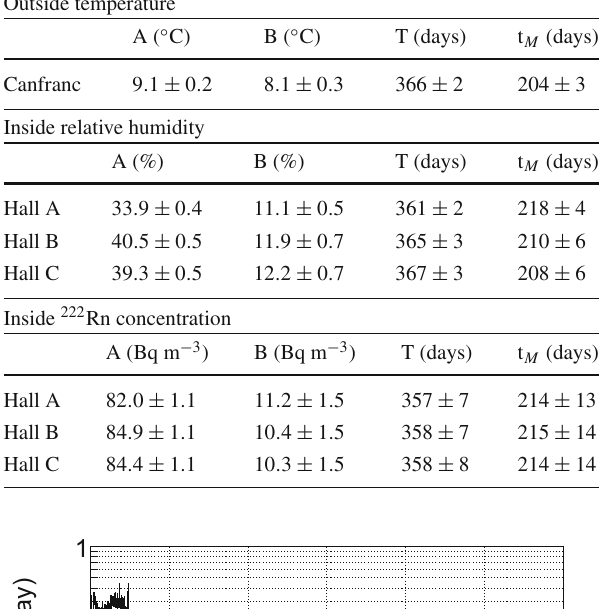
the inner volume of the shielding due to an accidental cut of the purging system. Second, we measured the efficiency at 1460.8 keV, (cid:4)( 1460 . 8 keV), using a source of 260 g of KCl located at several positions in the accessible volume around the HPGe, and another one of 20.6 g at several distances from the HPGe window. We have estimated a 10% systematic uncertainty for (cid:4)( 1460 . 8 keV) because the lack of measure- ments for sources located at the rear of the HPGe. The nor- malizationof (cid:4) R ( 1460 . 8keV)tothemeasured (cid:4)( 1460 . 8keV) gives the efficiencies for the 222 Rn gamma lines (Fig. 9). A Monte Carlo simulation with Geant4 [50] according to the known geometry of the HPGe detector agrees with the for- mer from 0.6 to 2.2 MeV (Fig. 9). The differences at low energy are due to the partial knowledge of the geometry. The best upper limit, 0.06 Bq m − 3 (95% C.L.), is obtained with the 351.9 keV gamma line. This value is one order of magnitude better than our previous estimate based on the NaI(Tl) data [51,52]. According to the ANAIS-112 back- ground model [52], this upper limit means that the contri- bution of the 222 Rn to the total rate is < 4 × 10 − 4 counts keV − 1 kg − 1 d − 1 in the region of interest, [1–6] keV, amount- ing to less than 0.01% of the background [12]. The possible contribution of some modulation of some tiny 222 Rn activity to the expected signal in ANAIS-112 is negligible because if we would take the above upper limit of 0.06 Bq m − 3 as a true 222 Rn concentration with a modu- lation amplitude ∼ 10%, similar to the one observed in the hall B (Table 4), its contribution to the ANAIS-112 modula- tion signal would be 4 × 10 − 5 counts keV − 1 kg − 1 d − 1 in the region [1–6] keV, much below the modulation observed by the DAMA/LIBRA collaboration [48] and the sensitivity of ANAIS-112 experiment